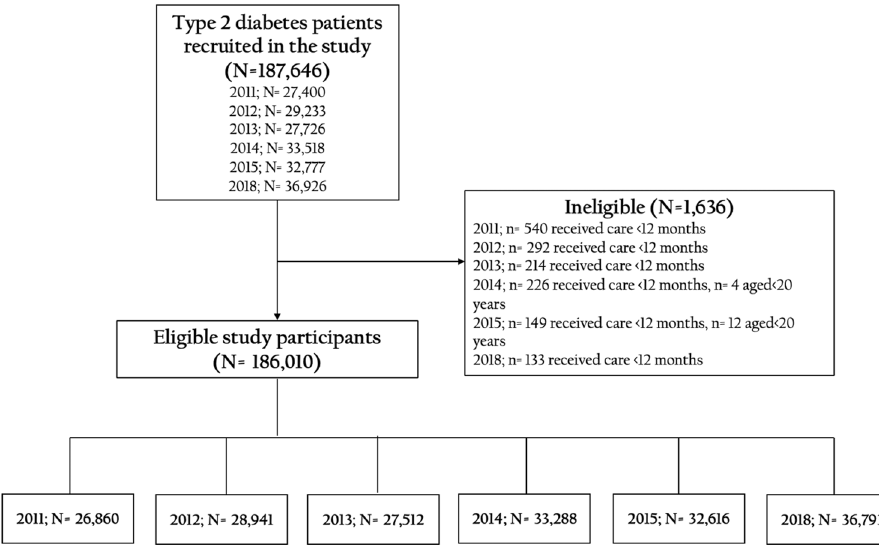
Figure 1. Flow of enrolled patients with type 2 diabetes receiving continuous care in Thailand from 2011 to 2015 and